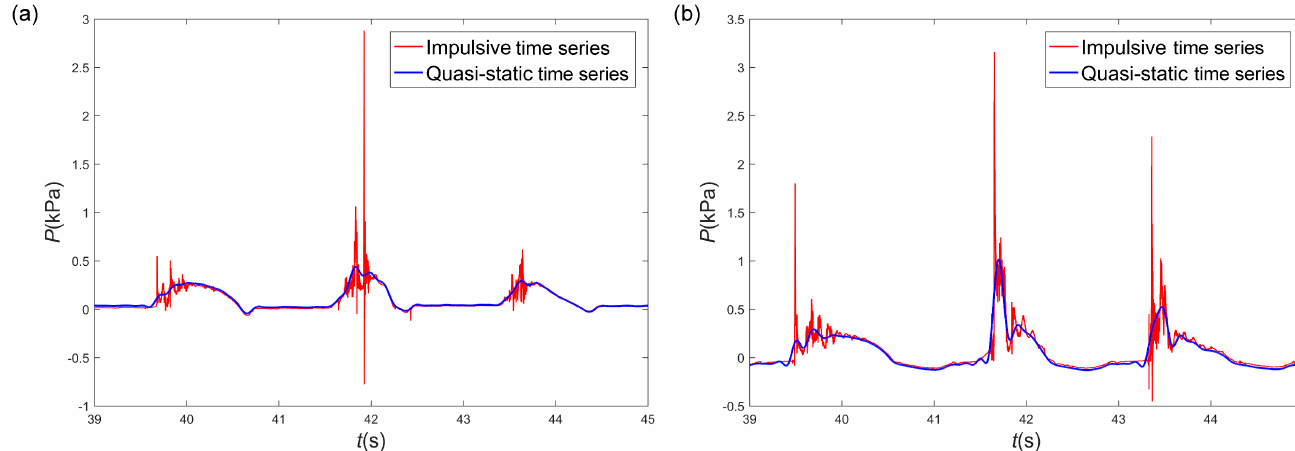
Figure 8. Time series of the decomposed impulsive wave pressure and quasi-static wave pressure of PS1 for the simple horizontal plate (C1).